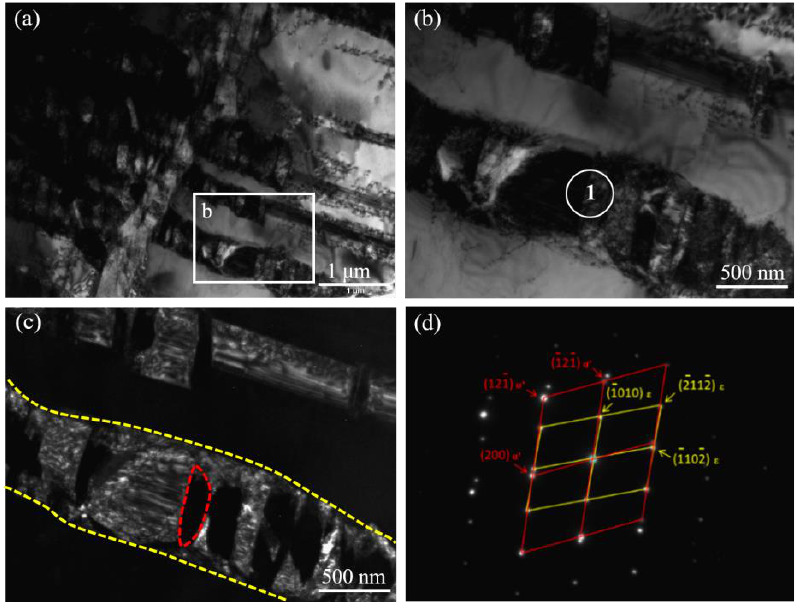
Figure 6. TEM microstructures of solution-treated specimen after 2.5% strain at 77 K: ( a ) bright-field image; ( b ) enlarged image of area b in ( a ); ( c ) dark-field image using (10 1̅ 0)ε reflection; ( d ) selected-area diffraction pattern corresponding to area 1 shown in ( b ), zone axis = [2 4̅ 2 3̅ ]ε, zone axis = [012]α′.